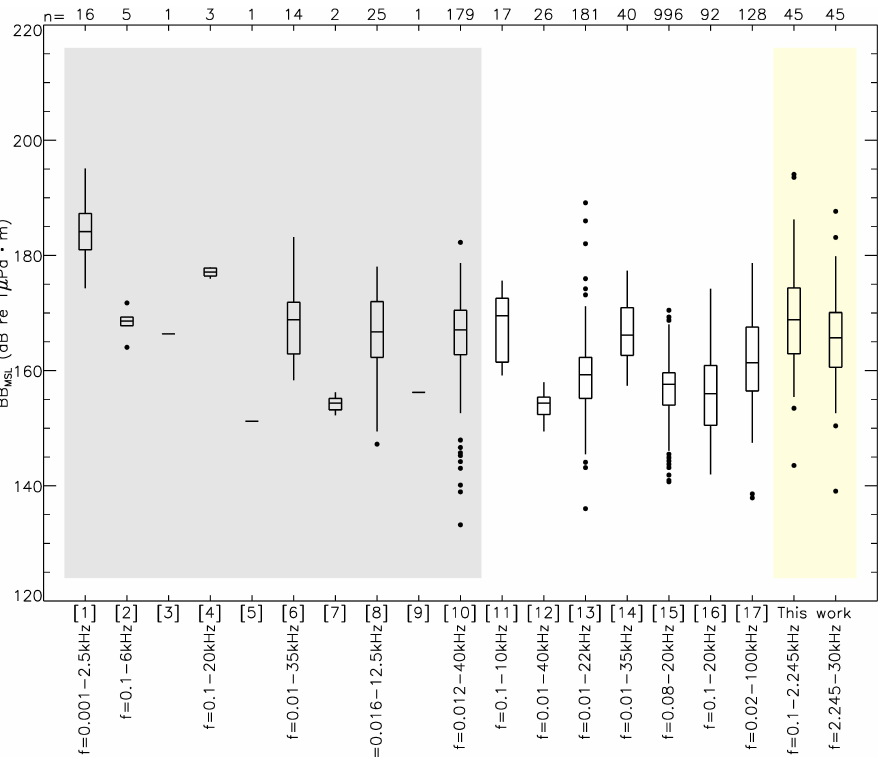
Figure 8. Broadband source levels gathered in [56]’s meta-analysis. Studies shown with the light grey background were not used in the authors’ analysis. References are provided as follows; [1]: [58], [2]: [59], [3]: [60], [4]: [53], [5]: [61], [6]: [54], [7]: [62], [8]: [63], [9]: [64], [10]: [65], [11]: [2], [12]: [5], [13]: [22], [14]: [66], [15]: [23], [16]: [67], and [17]: [55]. The bandwidth applied for each study is provided below each study’s number (that information is missing for studies [3], [5], [7], and [9]). The number of individual measurements ( n ) in each study is provided along the top abscissa. Boxplots are traced out for 5%, 25%, 75%, and 95% percentiles while the middle horizontal line is each sample’s mean. Outliers are shown as black dots. Our contribution to this figure is shown with the light yellow background along both low- (0.1 kHz to f 0.5 ; see text) and mid-frequency ( f 0.5 to 30 kHz; see text) domains. From references [1] to [17], the figure was reproduced with permission from Miles J. G. Parsons, A Review and Meta-Analysis of Underwater Noise Radiated by Small ( < 25 m Length) Vessels; published by Journal of Marine Science and Engineering,